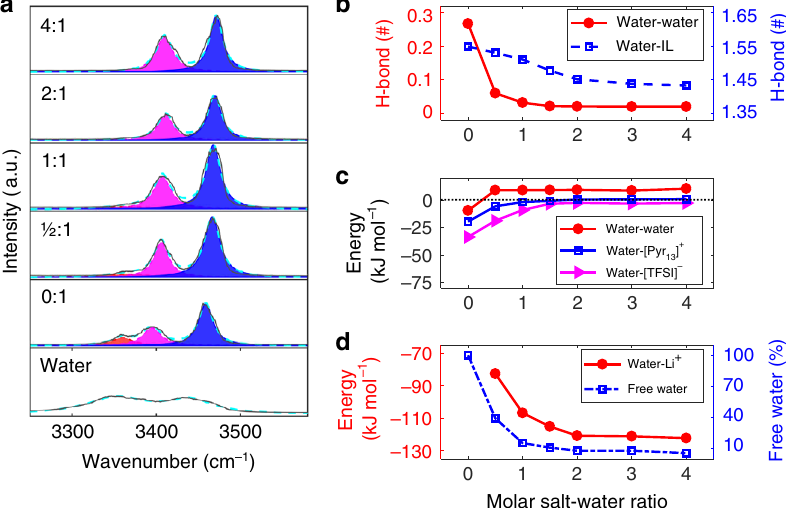
Fig. 3 Microscopic understanding of the salt effect on water in humid ionic liquids. a MD-calculated infrared spectroscopy (IR) spectra of O – H bond in pure water, humid 1-methyl-1-propylpyrrolidinium bis(tri fl uoromethylsulfonyl)imide ([Pyr 13 ][TFSI]), and humid [Pyr 13 ][TFSI] with different molar salt – water ratios. The gray lines represent IR spectra. The red, pink, and blue regions are the fi rst, second, and third fi tting spectra, respectively. The cyan dash lines represent the summation of the fi tting spectra. b H-bonds between water molecules (left axis) and between water molecules and ionic liquid ions (right axis). c Interaction energy coming from van-der-Waals and coulombic interactions between water and water, [Pyr 13 ] + and [TFSI] − . d Interaction energy between water and Li + (left axis), and the proportion of free water (right axis) as a function of the molar salt – water